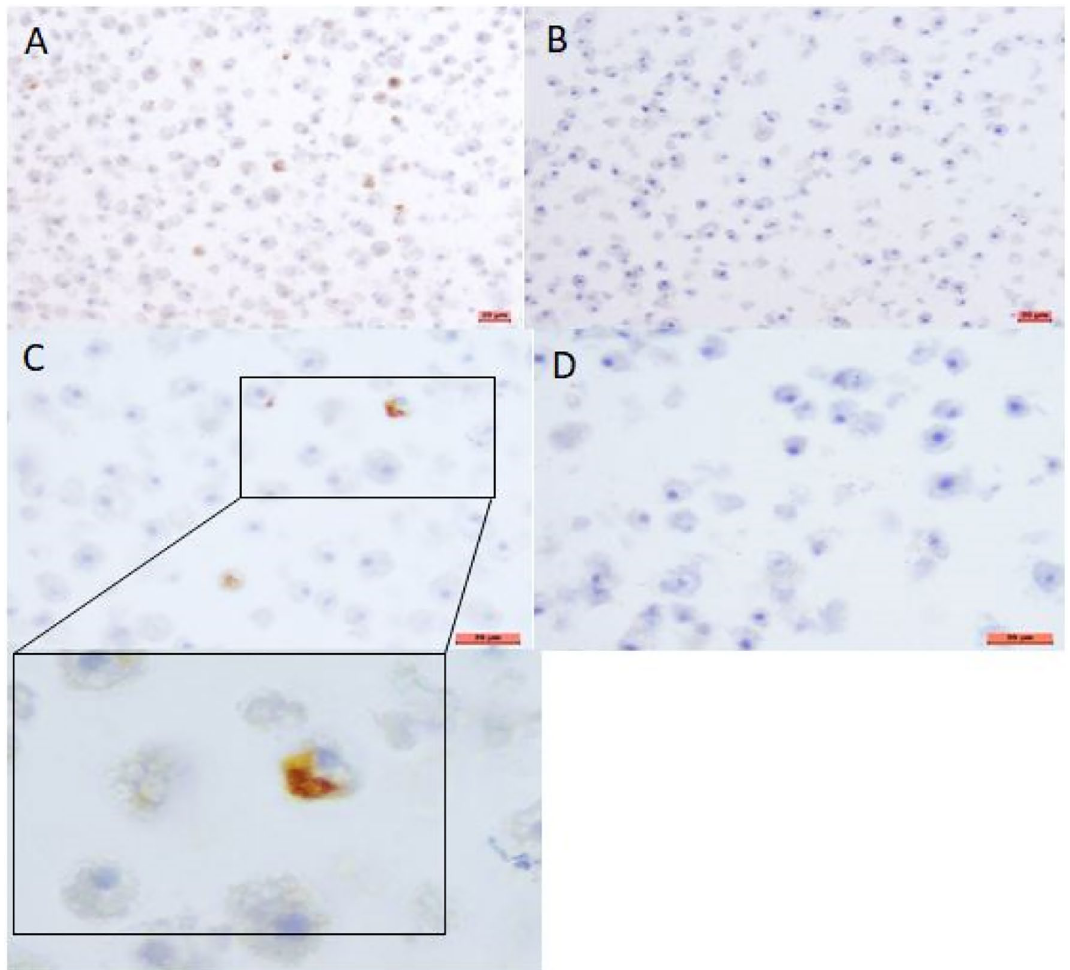
Figure 4. Immunohistochemistry results. ( A ) and ( C ) positive control corresponding to Francisella tularensis in amoebae labeled with FB11 monoclonal antibody 1/1000 in Leica dilution buffer. ( B ) and ( D ) negative control corresponding to Francisella philomiragia in amoebae labeled with FB11 monoclonal antibody. ( E ) and ( G ) show Francisella tularensis labeled in the cytosol of liver cells. ( F ) and ( H ) show the background generated by the Leica revelation system without antibodies. A, B, E and F: objective × 20. C, D, G, and H: objective × 40. Added insert: objective ×